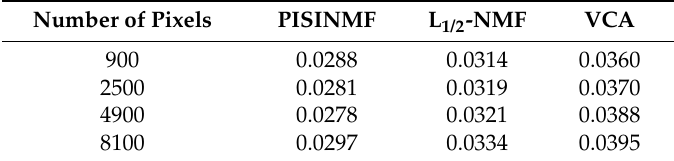
Figure 12. Experimental results with different numbers of pixels in the scene: ( a ) RMSE; ( b ) SAD. Table 7. SAD comparison with different numbers of pixels in the scene.